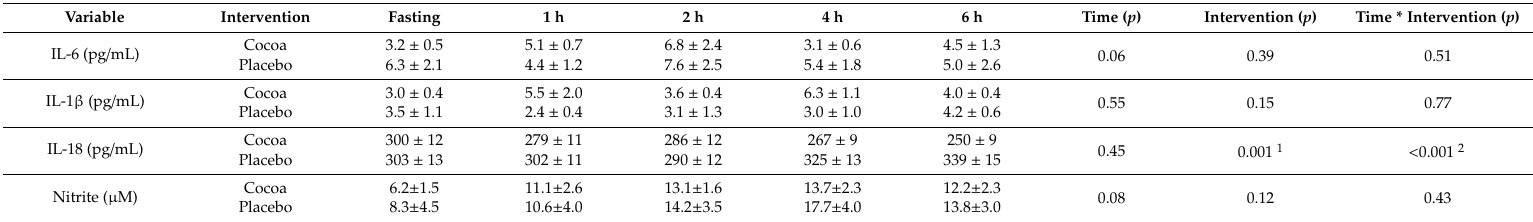
Table 3. Postprandial serum levels of inflammatory cytokines and nitrite in adults with type 2 diabetes following a high-fat meal challenge with a polyphenol-rich cocoa or placebo beverage.